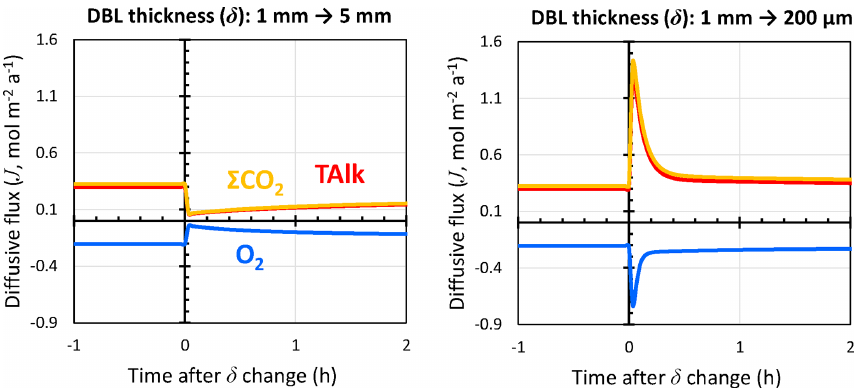
Figure 9. Response of TAlk, (cid:54) CO 2 , and O 2 diffusive fluxes through the DBL to instantaneous changes in the DBL thickness ( δ ) as caused by, for instance, a stirred benthic chamber. Positive values represent solute fluxes toward the bottom waters, while negative values represent solute fluxes toward the